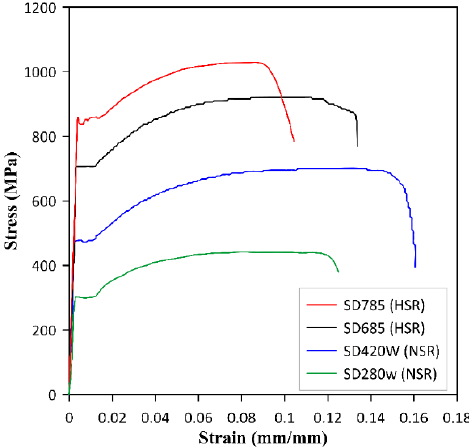
Figure 2. Stress – strain curves of longitudinal rebar. Figure 2. Stress–strain curves of longitudinal